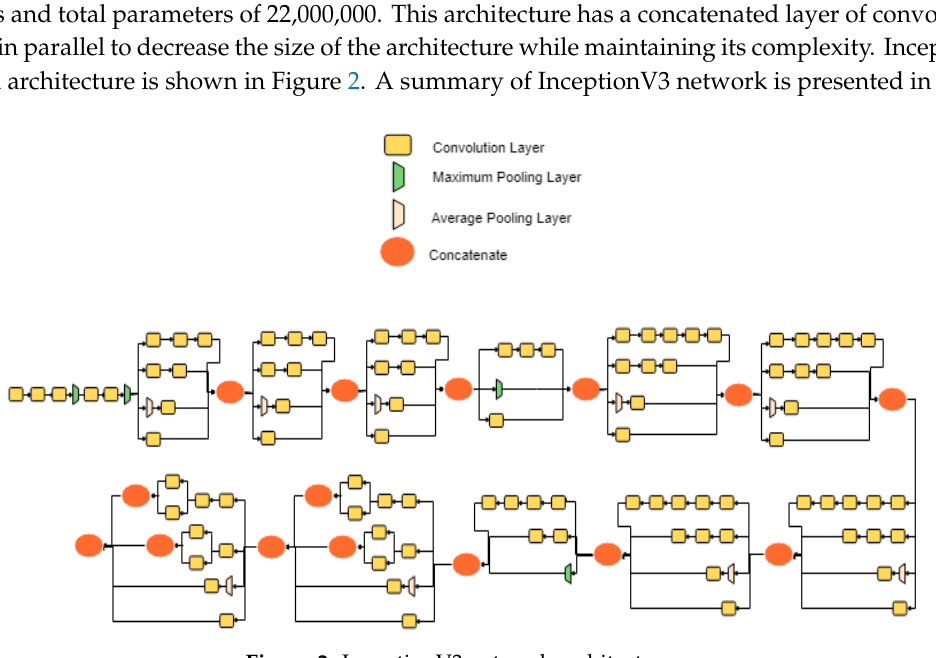
Figure 2. InceptionV3 network architecture.